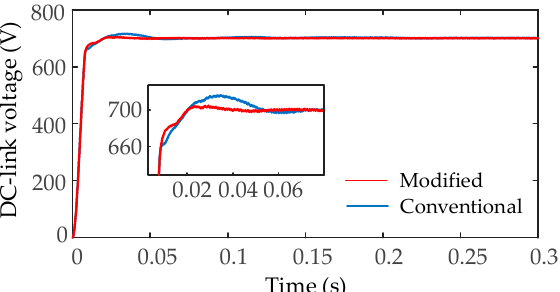
Figure 12. Comparison of dc-link voltage tracking performance under stationary operating conditions ( irradiance S = 1000 W/m 2 , module temperature T = 25 ◦ C )